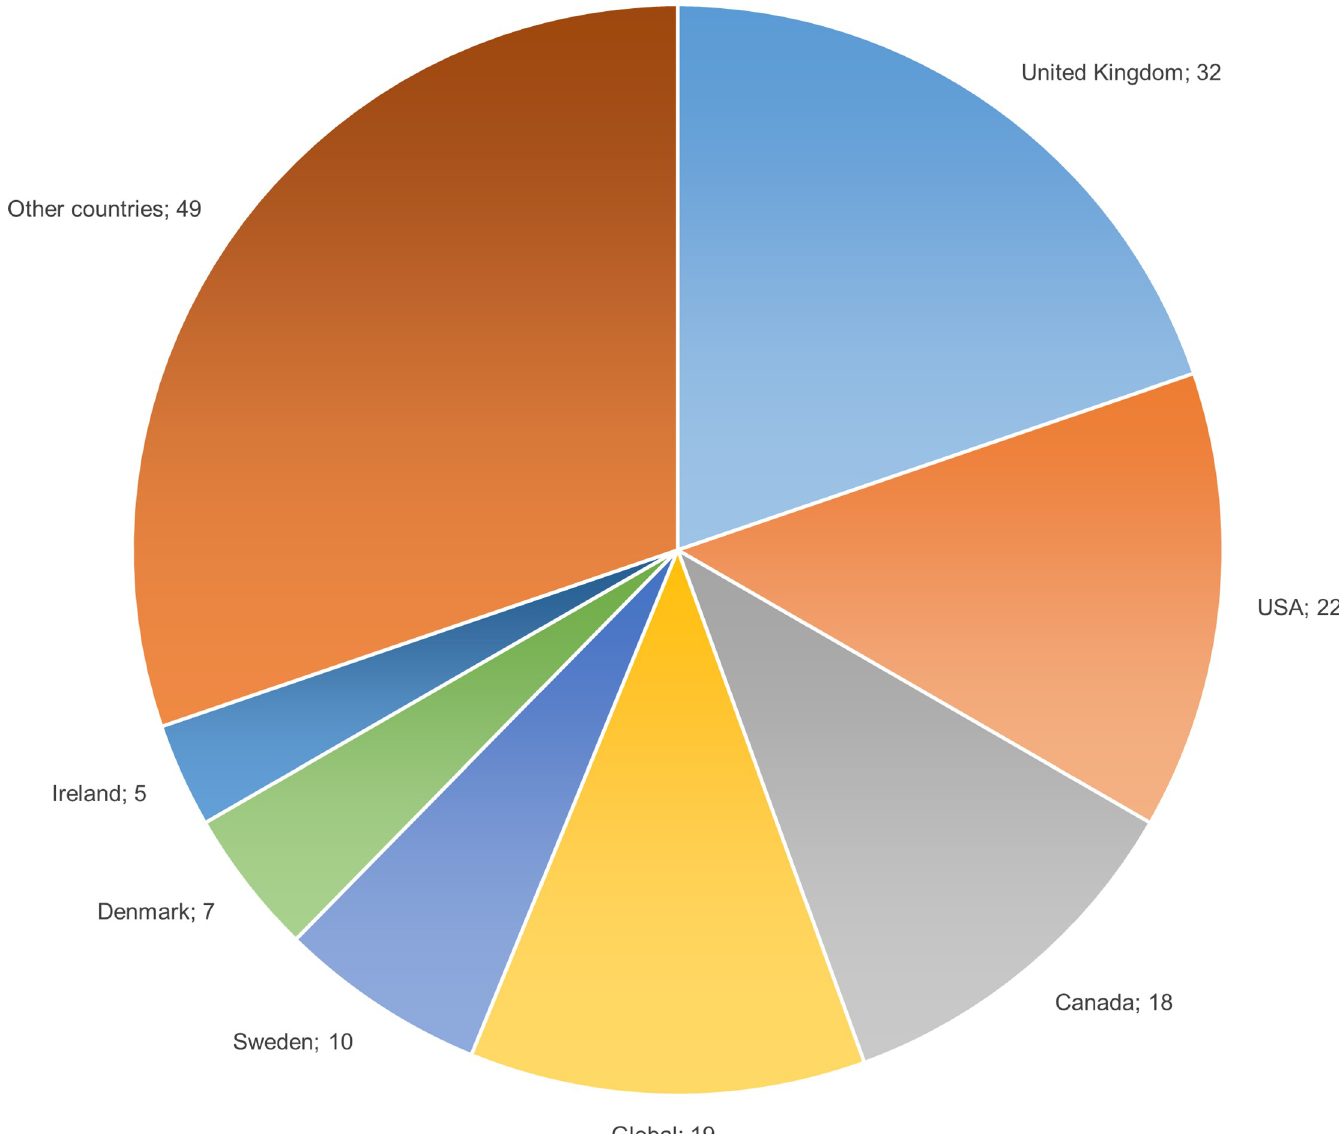
Fig 3. Countries studied in the publications of the corpus. Numbers refer to the number of studies on a country. Eleven publications include studies on different countries. ‘Other countries’ cover 35 countries and areas studied between 1 and 4 times.